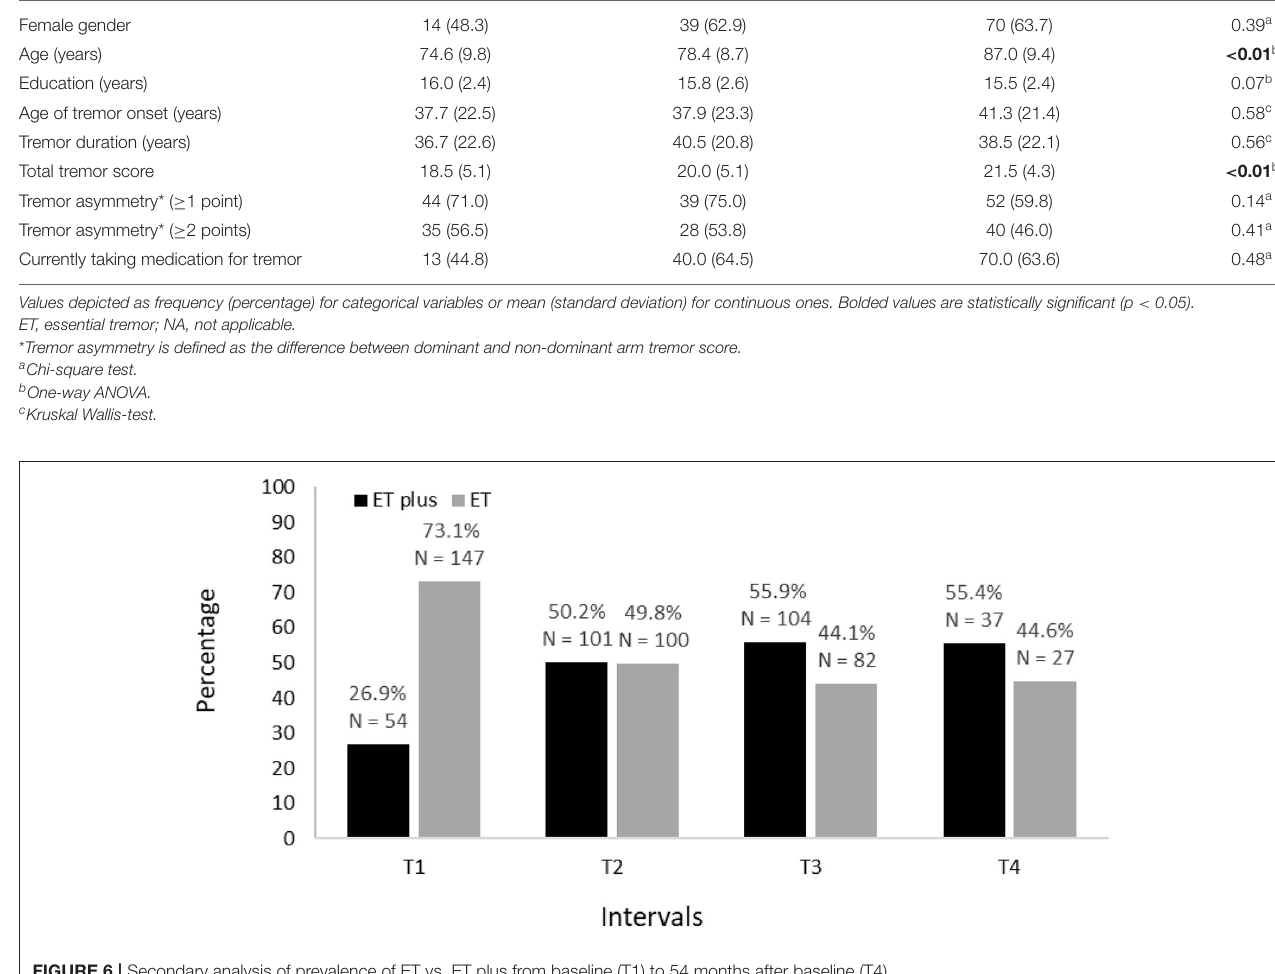
FIGURE 6 | Secondary analysis of prevalence of ET vs. ET plus from baseline (T1) to 54 months after baseline